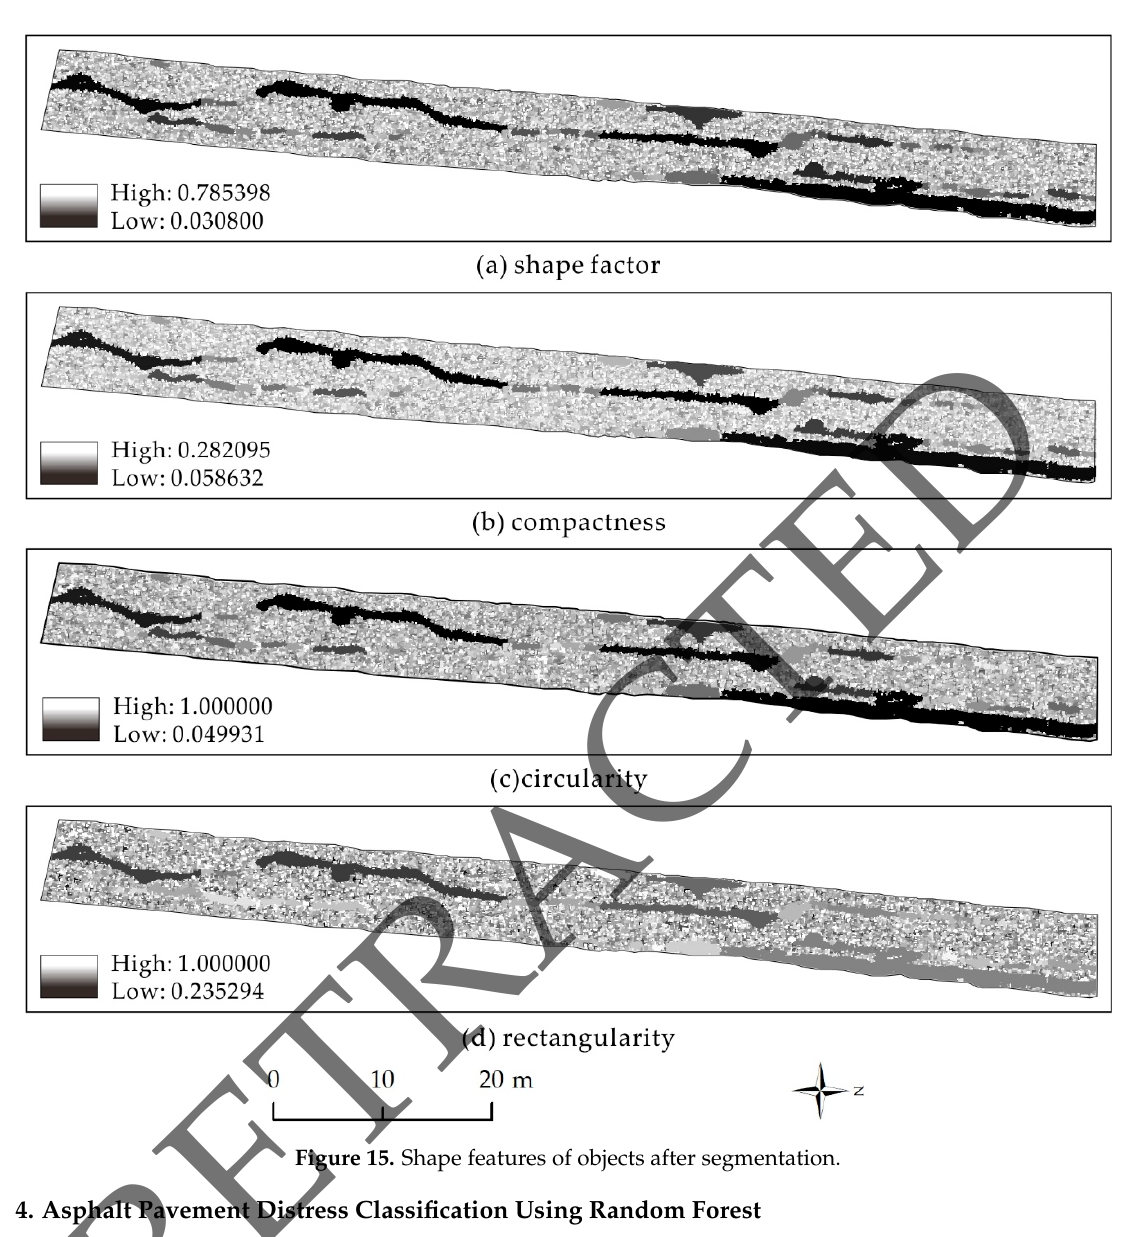
Figure 15. Shape features of objects after segmentation.